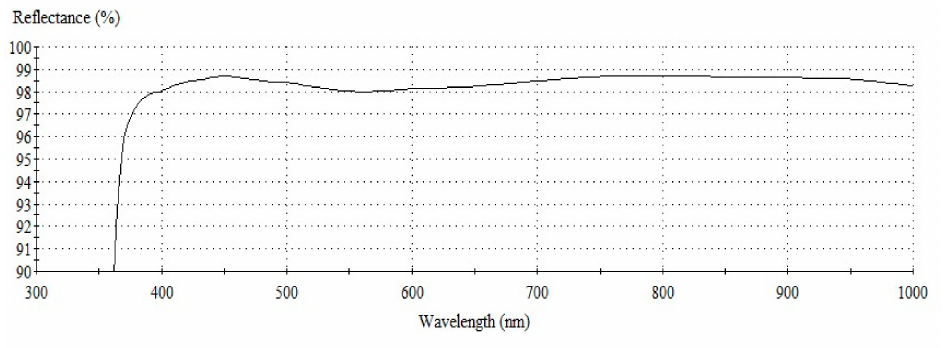
Figure 2. Design spectrum for high reflectivity silver